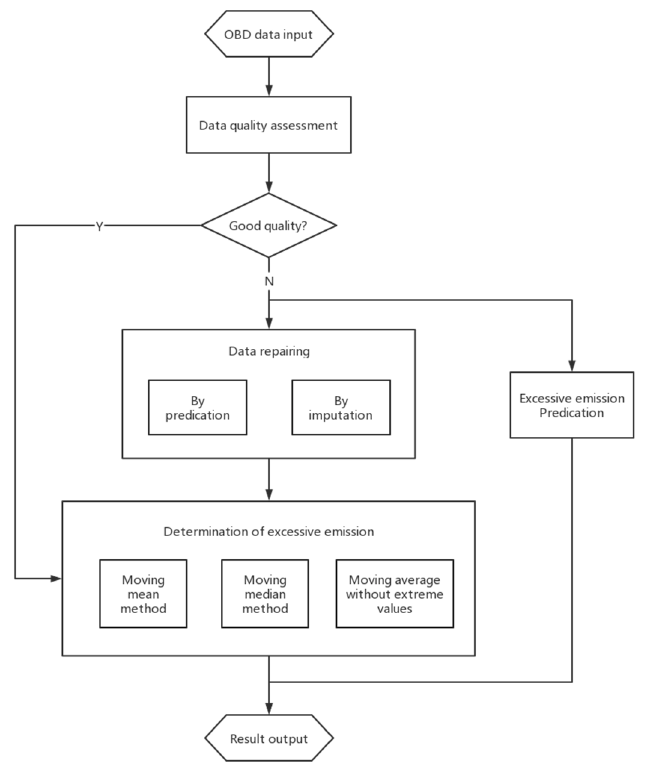
Figure 1. The framework of the process to determine excessive emissions.